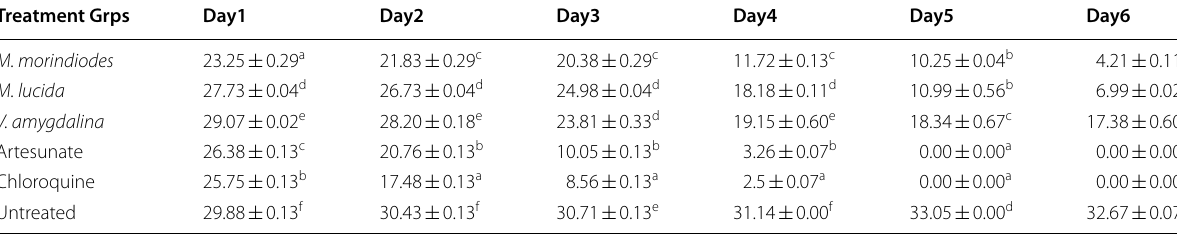
Values were expressed as mean standard deviation (SD). Values with different superscripts (Alphabets) in a column are significantly different ( p < 0.05) from each ± other. This implies that for each day, values with superscript a are the least value, followed by b then c, d e to f (highest). For example, at day 1, the lowest values for percentage parasitaemia were recorded in mice treated with M. morindiodes followed by that of chloroquine, while the highest parasitaemia was in untreated mice. These differences are statistically significant (all the values did not have similar superscript). At days 5 and 6, mice treated with artesunate and chloroquine have the least values for parasitaemia and both the same superscripts (a). This means they are not significantly different from one another Mean values were from five mice observed in each group